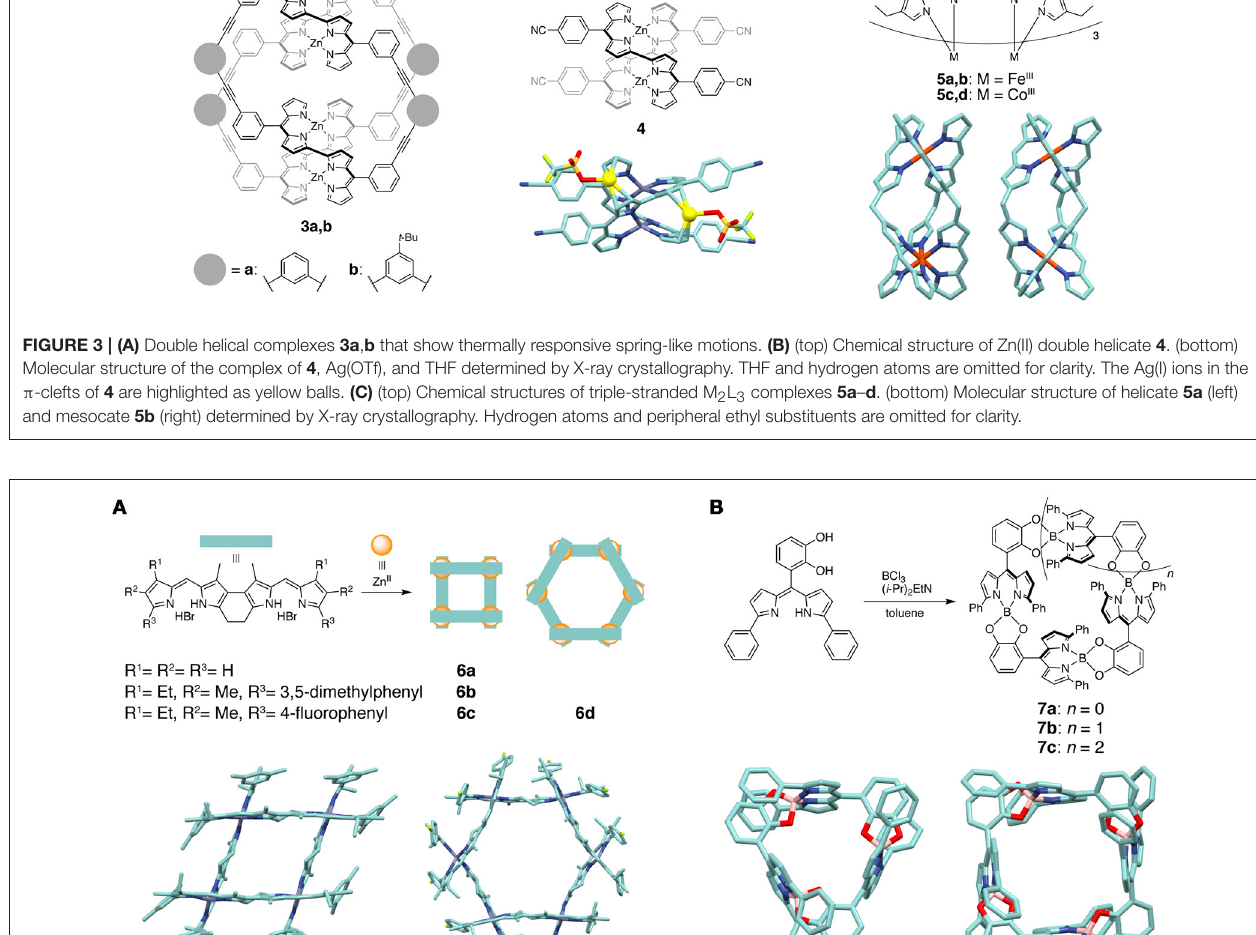
(dipyrrinato)(catecholato)boron complex moieties are